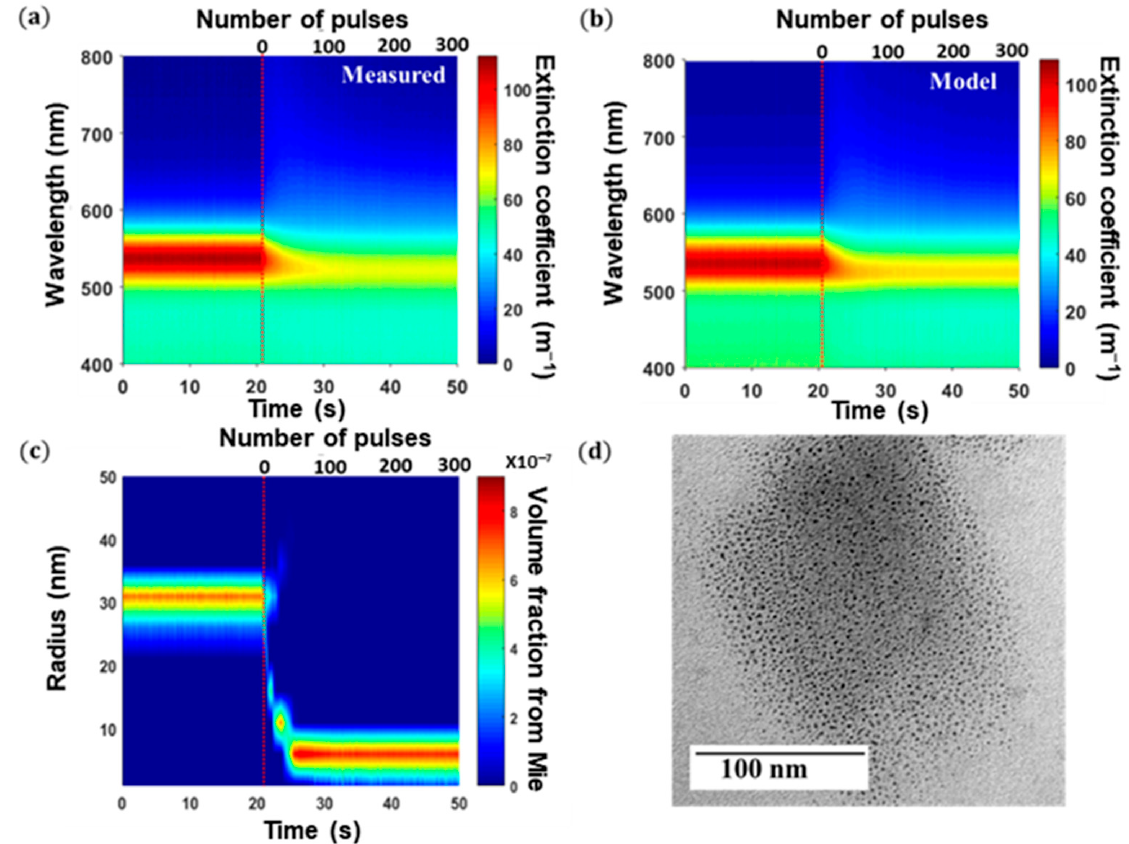
Figure 10. Evolution of ( a ) the measured and ( b ) modeled extinction spectra of Au colloids during laser exposure. ( c ) Evolution of the NP size determined from extinction spectroscopy during laser exposure. The red dashed line shows the beginning of laser exposure. The radius step is DR = 5 nm. An interpolation was used to plot the data. ( d ) TEM image of S6 NPs after 30 min laser exposure. The laser fluence, wavelength, and repetition rate were 3.2 J · cm − 1 , 1064 nm, and 10 Hz, respectively.